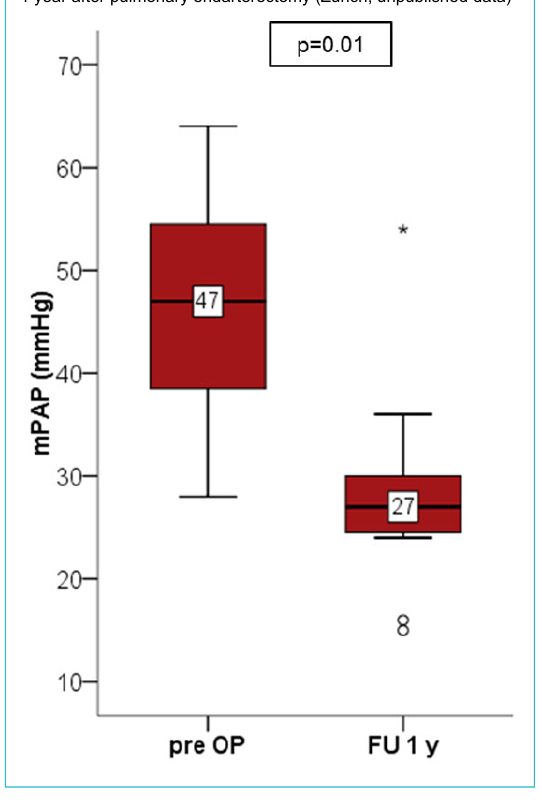
Figure 16: Reduction of mean pulmonary arterial pressure (mPAP) 1 year after pulmonary endarterectomy (Zurich, unpublished data)